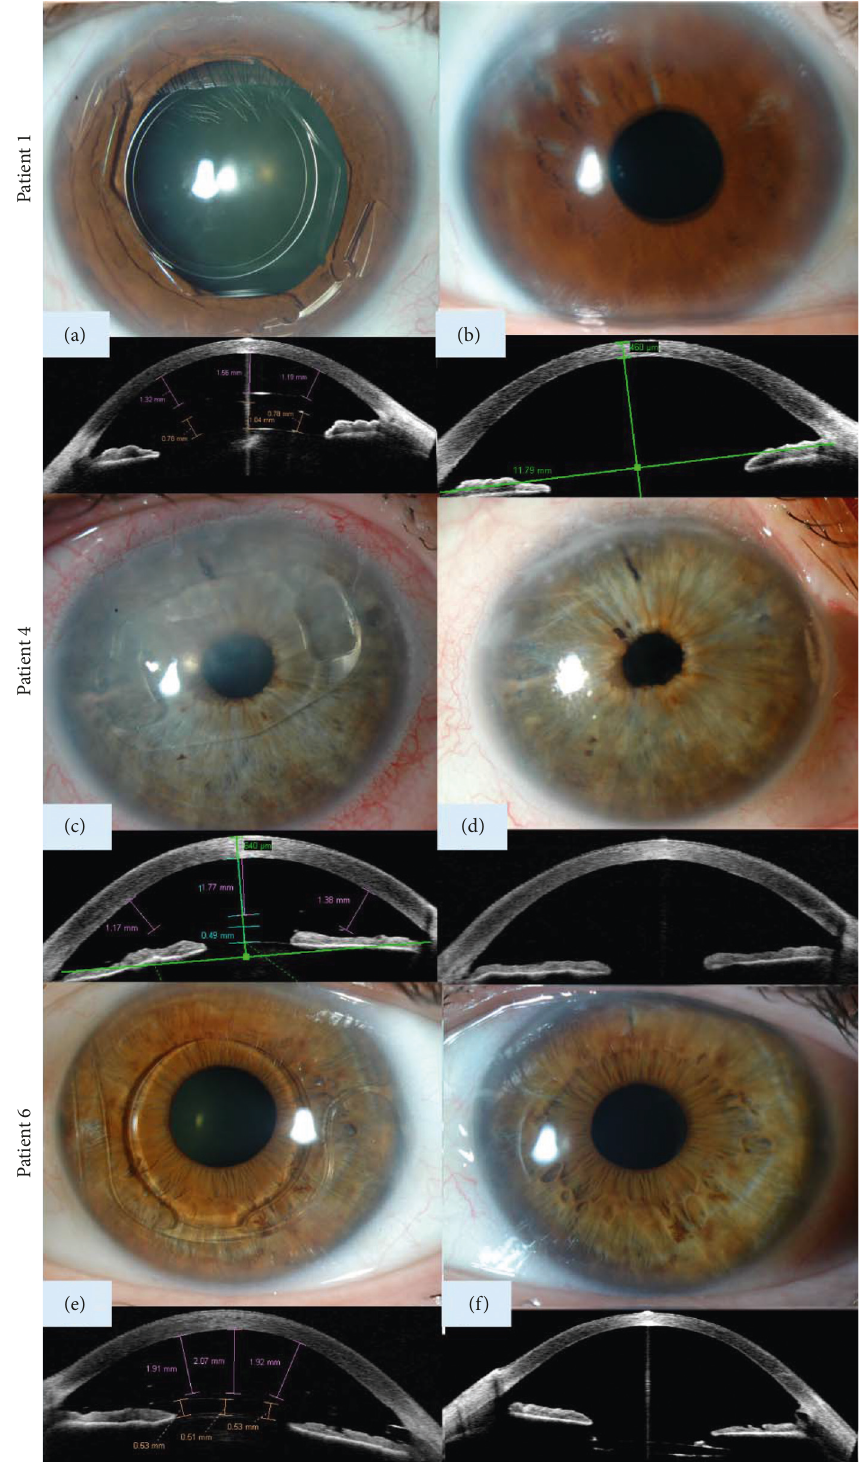
Figure 1: Preoperative and postoperative slit-lamp images and Visante OCTs of three of the cases: (a, b) patient 1 with I-Care phakic intraocular lens (pIOL), (c, d) patient 4 with Artisan pIOL, (e, f) and patient 6 with GBR/Vivarte